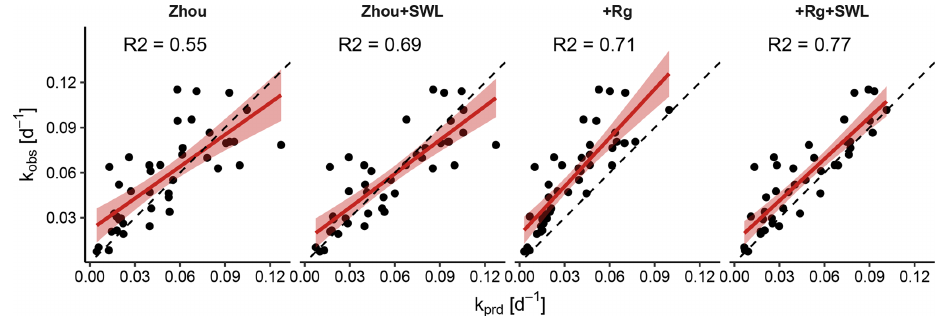
Figure 7. Observed plotted against predicted values of the decay coefficient k (Eq. 14) for the four model variants. Points represent individual dry-down events, for which a linear fit with confidence intervals is shown in red; the one-to-one line is dashed. Three outlying events for which k deviated exceedingly from the other events were removed.